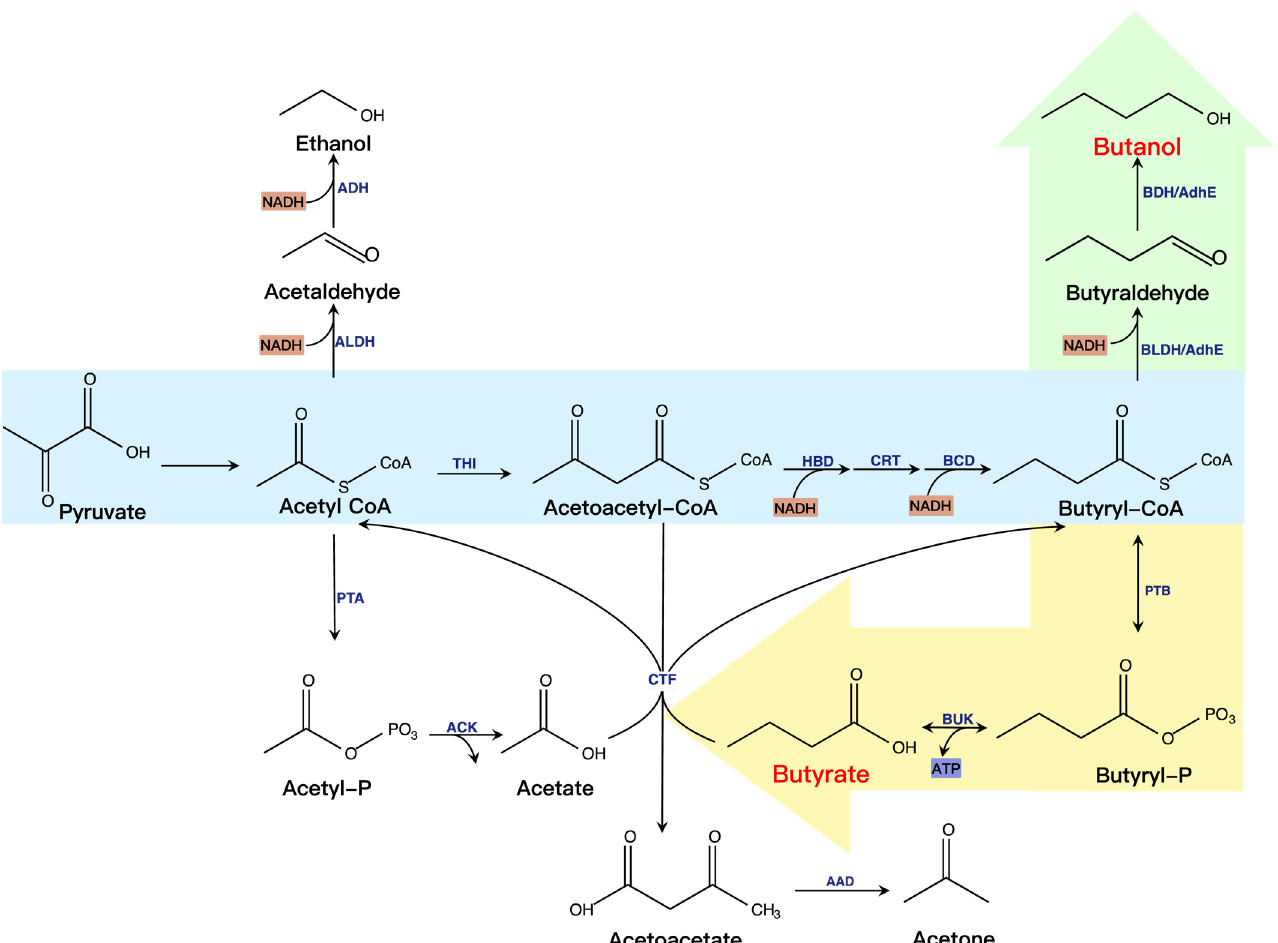
Figure 4. Synthesis of butanol and butyrate. The essential microbial metabolic pathways, enzymes, cofactors (e.g., NADH), and energy transfer compounds (e.g., ATP) are involved in butanol and butyrate formation. Green is the butanol synthesis pathway in the solvent-producing phases. Yellow is the butyrate synthesis pathway in the acid-producing phase.